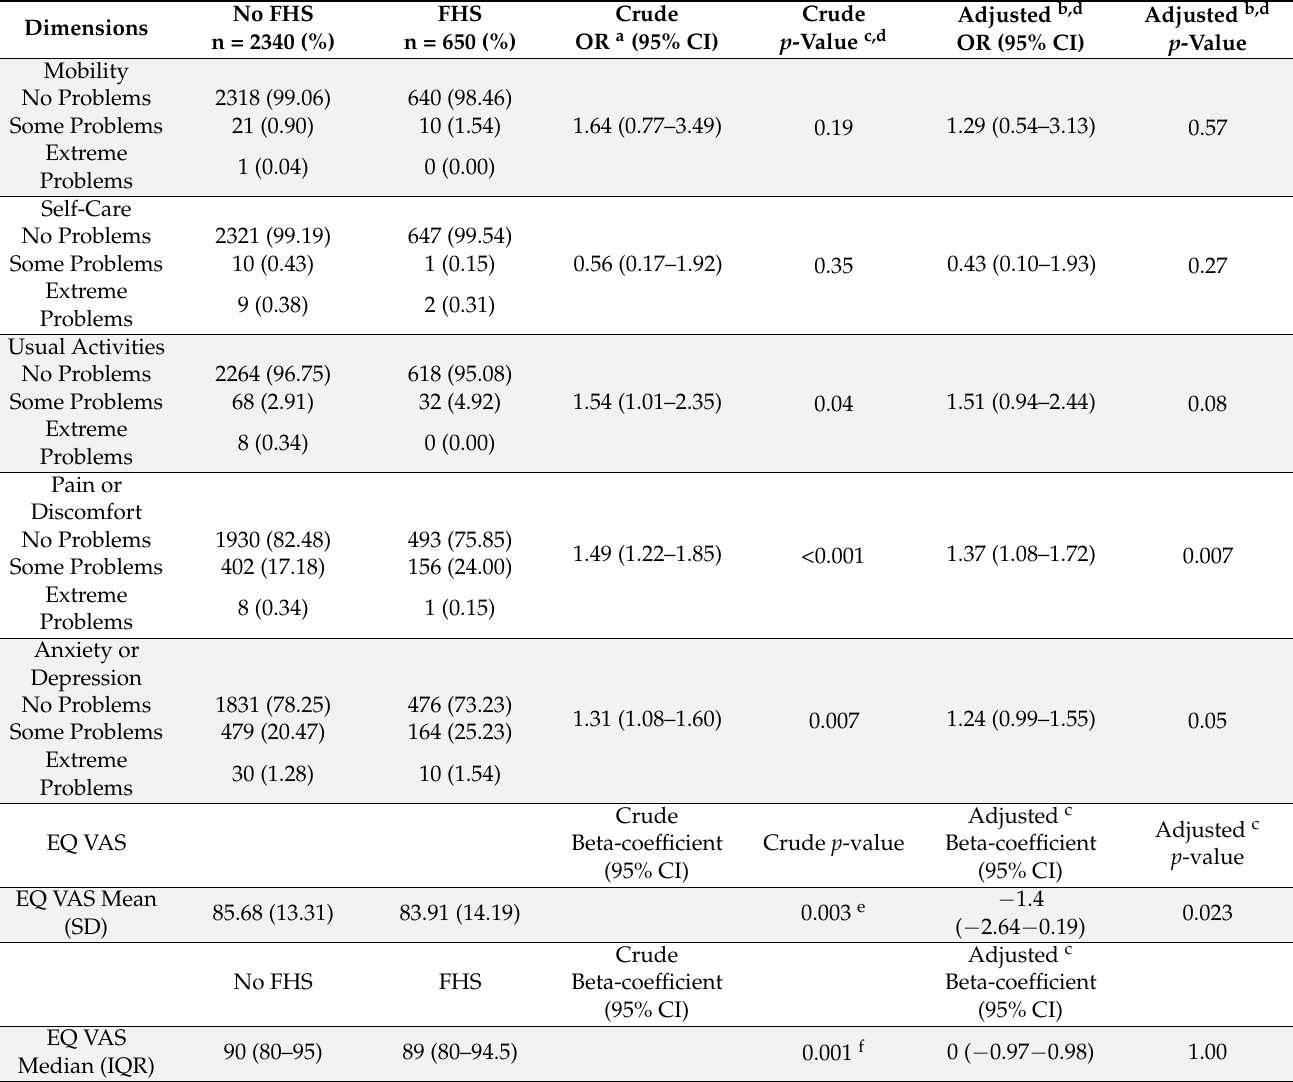
Table 1. Distribution of EQ-5D in relation to food hypersensitivity (FHS) a